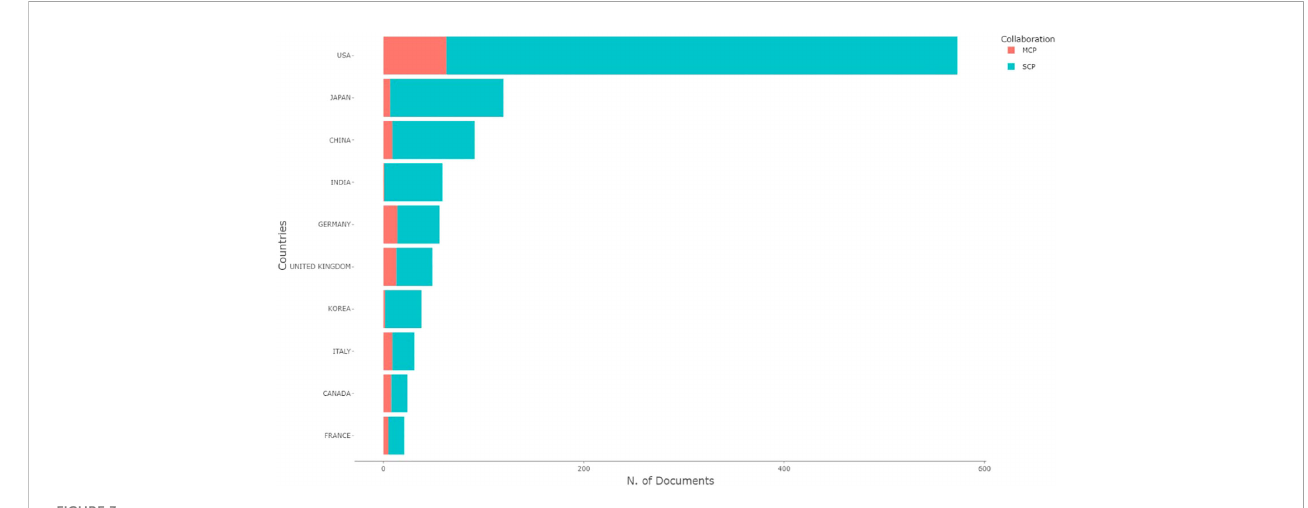
FIGURE 3 Publications with single and multiple country